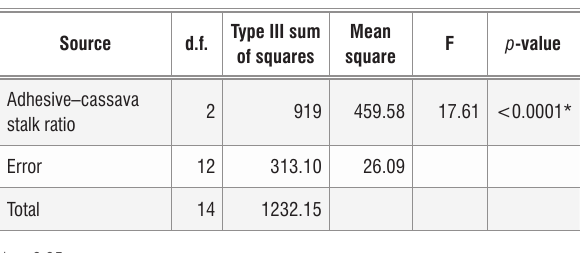
Analysis of variance of the effect of material variables on thickness swelling